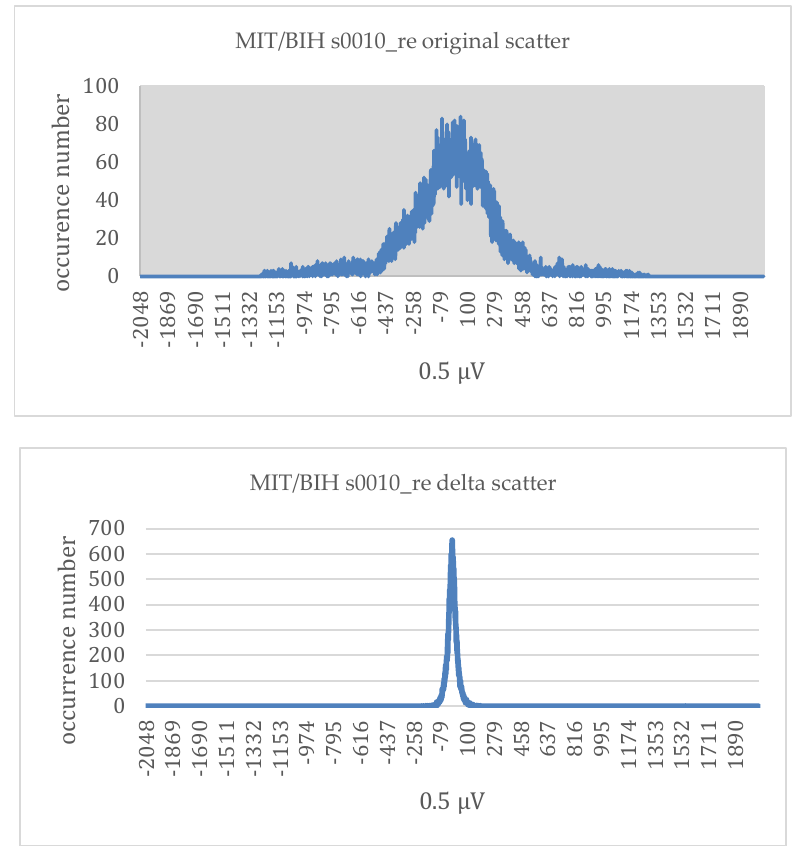
Figure 15. Comparison of probability of occurrence of each distinct symbol for ECG (original) volume and delta volume variance with MIT s0010_re.